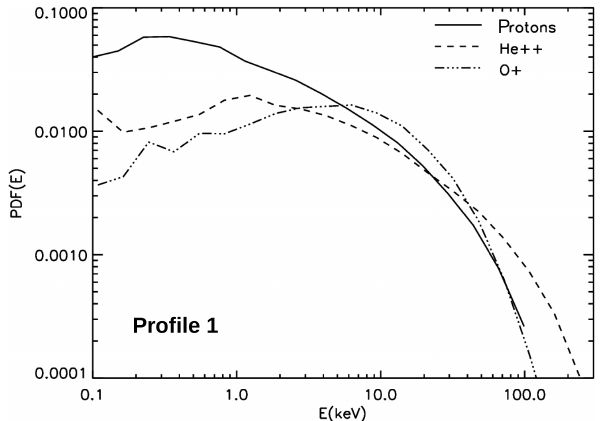
Figure 7. PDF of protons and heavy ions in the presence of profile 1 and A 0 /(cid:96) =